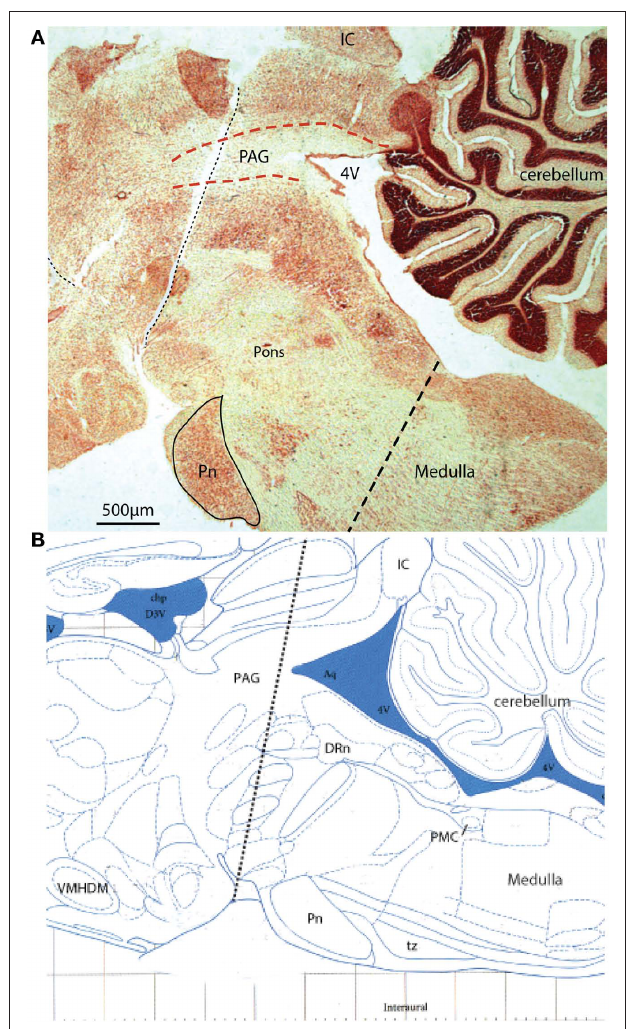
Figure 9 | Acute sequential hindbrain transections. (A) Histological parasagittal section (0.18 mm lateral) through hindbrain showing the mid-collicular line of transection (Neutral red stained section) and (B) annotated schematic (Paxinos and Watson, 2007) of the acute brainstem transections during active filling and voiding. The initial transection dissociated the rostral tissues from the brainstem (e.g., hypothalamic nuclei) leaving the brainstem intact. Voiding remained unaffected by this intervention. The second transection (shown) effectively disrupted the rostral periaqueductal gray (PAG), and resulted in loss of coordinated voiding, although filling responses remained. DRn, dorsal raphe nucleus; IC, inferior colliculus, Pn, pontine nucleus; tz, trapezoid body, VMHDM, ventromedial hypothalamic nucleus